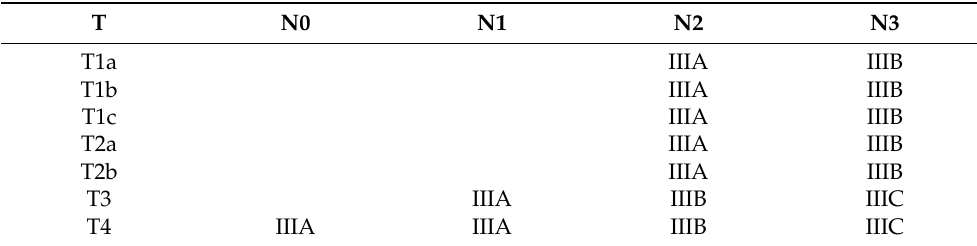
Table 1. Descriptors of tumors (T) and nodes in TNM eighth edition, to define stage III lung cancer (adapted from